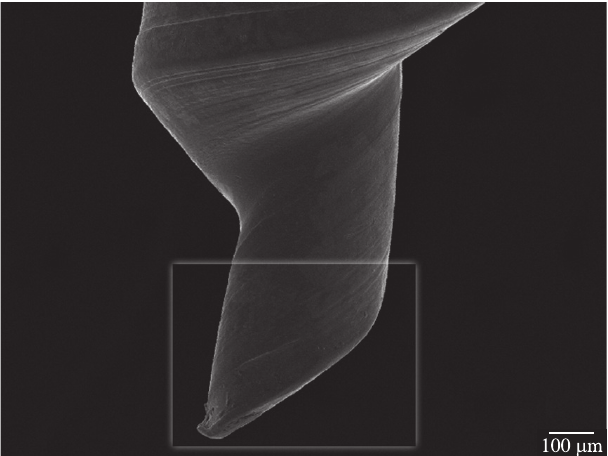
Figure 2. SEM photomicrograph of the surface morphology of the tip of a retrieved mini-implant (used for 12 months). Original magnification at 100×. The highlighted portion is the part comparable to the mini-implants in Figure